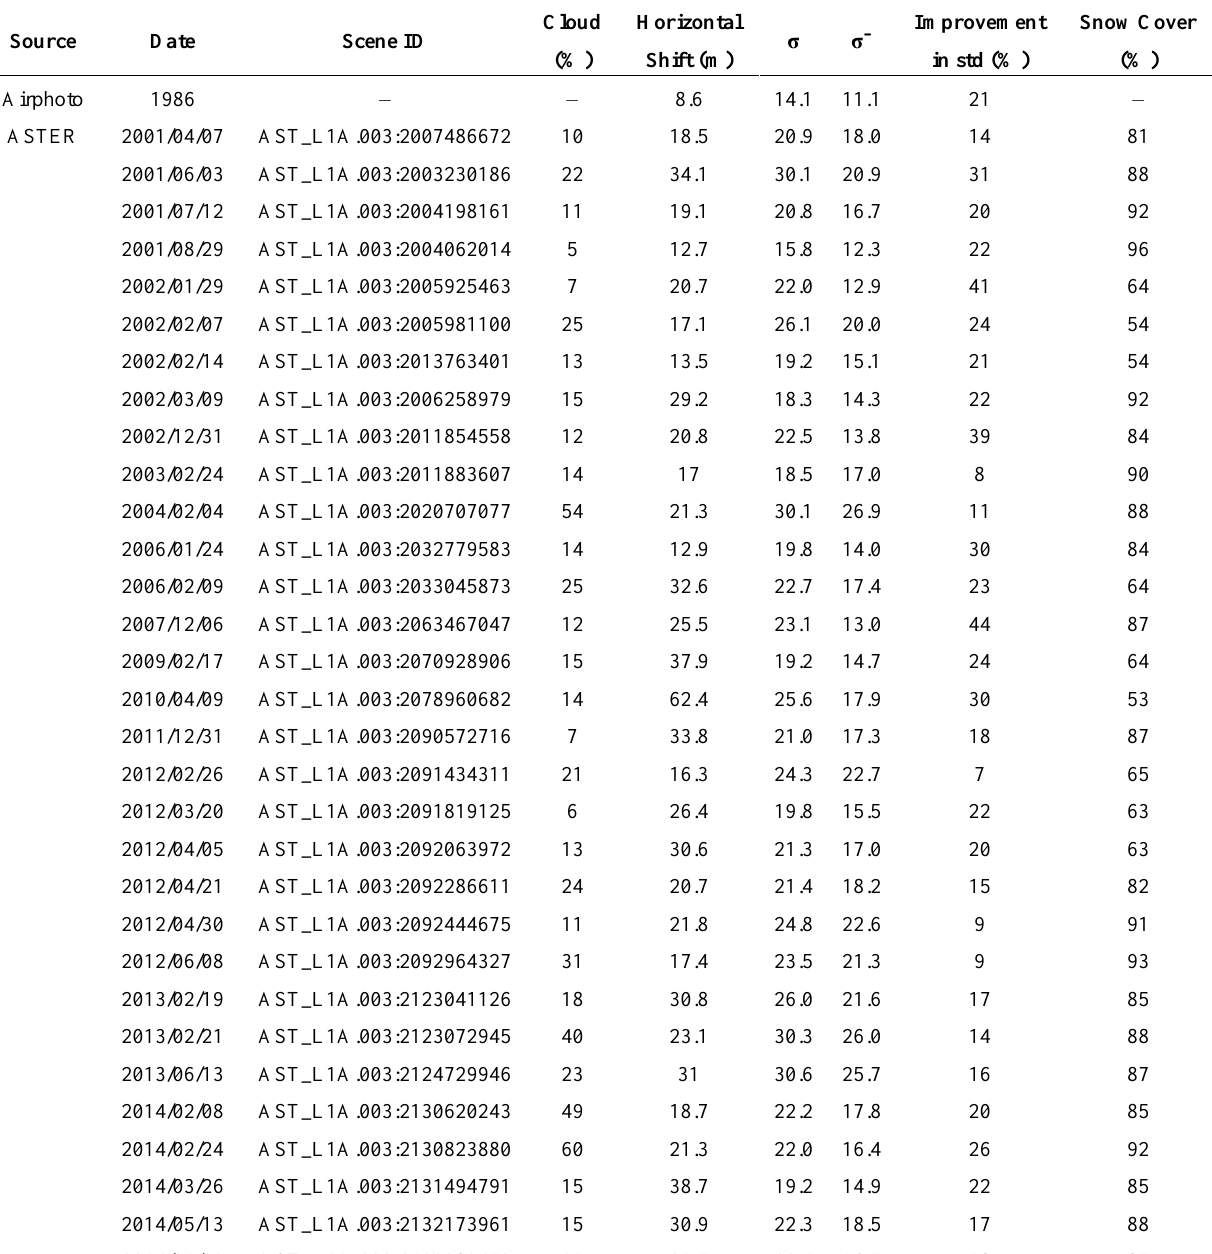
Table 1. Summary of Digital Elevation Model (DEM) data and co-registration. σ refers to the original standard deviation (std) of elevation difference (dh) for off-glacier terrain between each DEM and the Shuttle Radar Topography Mission (SRTM) DEM. σ ¯ denotes the standard deviation after co-registration. Cloud cover refers to the entire scene, snow cover only to Fox and Franz Josef